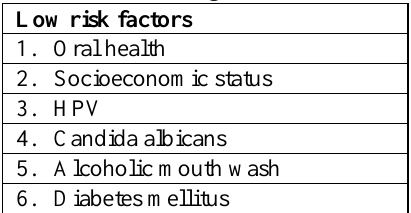
Table 2: Low risk factors for oral